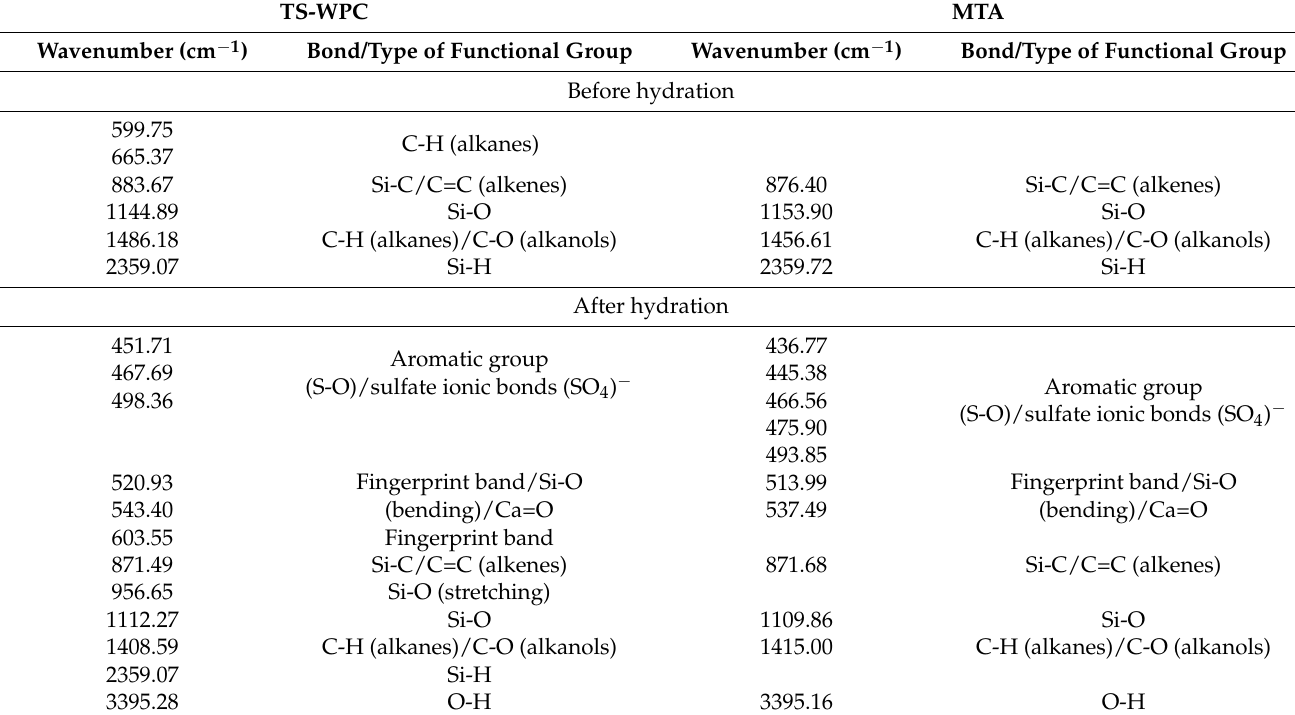
Figure 1. ( a ) FT-IR spectra and ( b ) XRD pattern results of the tricalcium silicate-white Portland cement (TS-WPC) and the commercial mineral trioxide aggregate (MTA) samples before and after hydration. Table 1. FT-IR peak